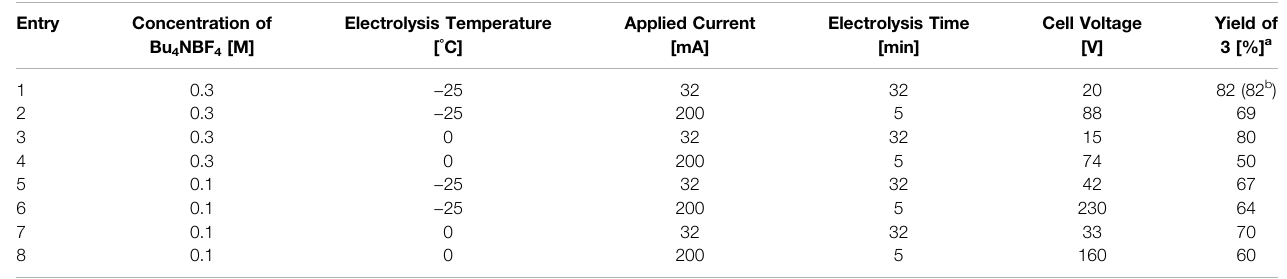
TABLE 3 | Effect of applied current and concentration of supporting electrolyte. Electrolysis Temperature Entry Concentration of [ ° Bu 4 NBF 4 [M]